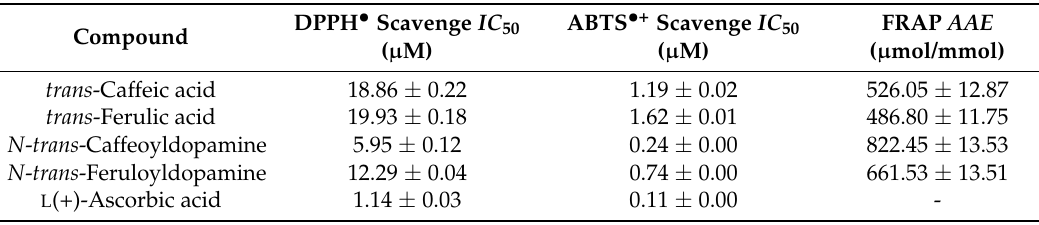
Table 2. Antioxidant activity of tested compounds.